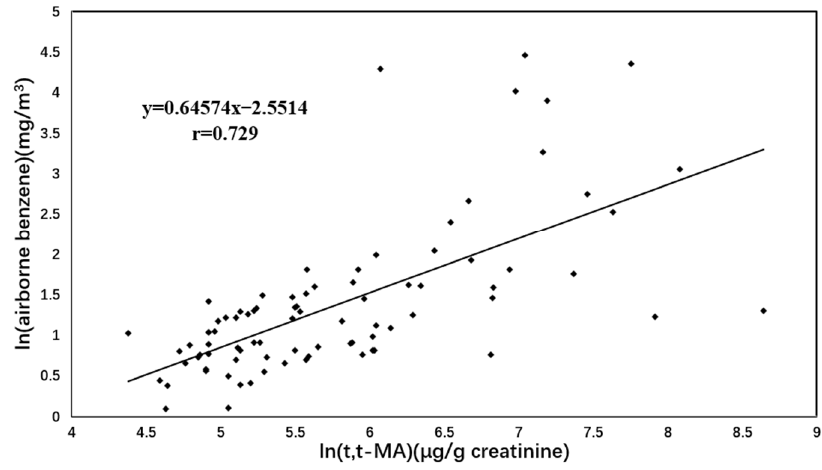
Figure 2. Correlation between natural logarithmic transformed benzene exposure levels (mg/m 3 ) and t, t ‐ MA values ( μ g/g creatinine).